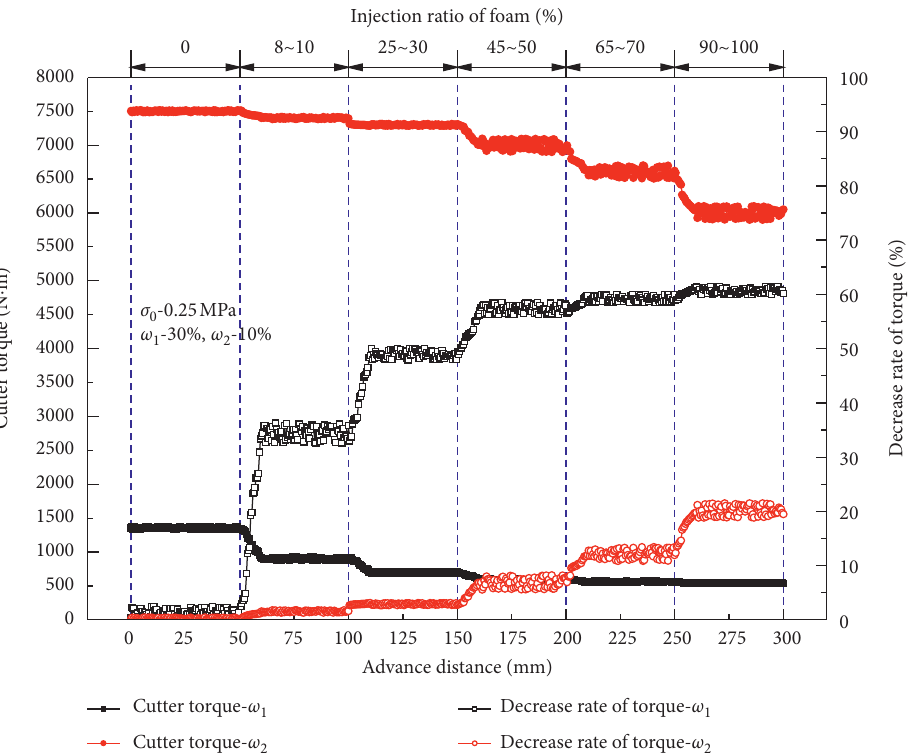
Figure 19: Effect of foam conditioning and soil water contents on cutter torque at soil pressure 0.25 MPa.